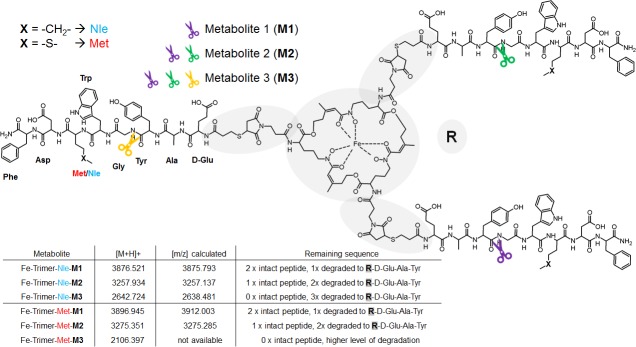
Propsed composition of metabolites calculated by computational assistance.Comparison of molecular weight of metabolites (measured vs. calculated) and proposed structure of metabolites including major cleavage site.